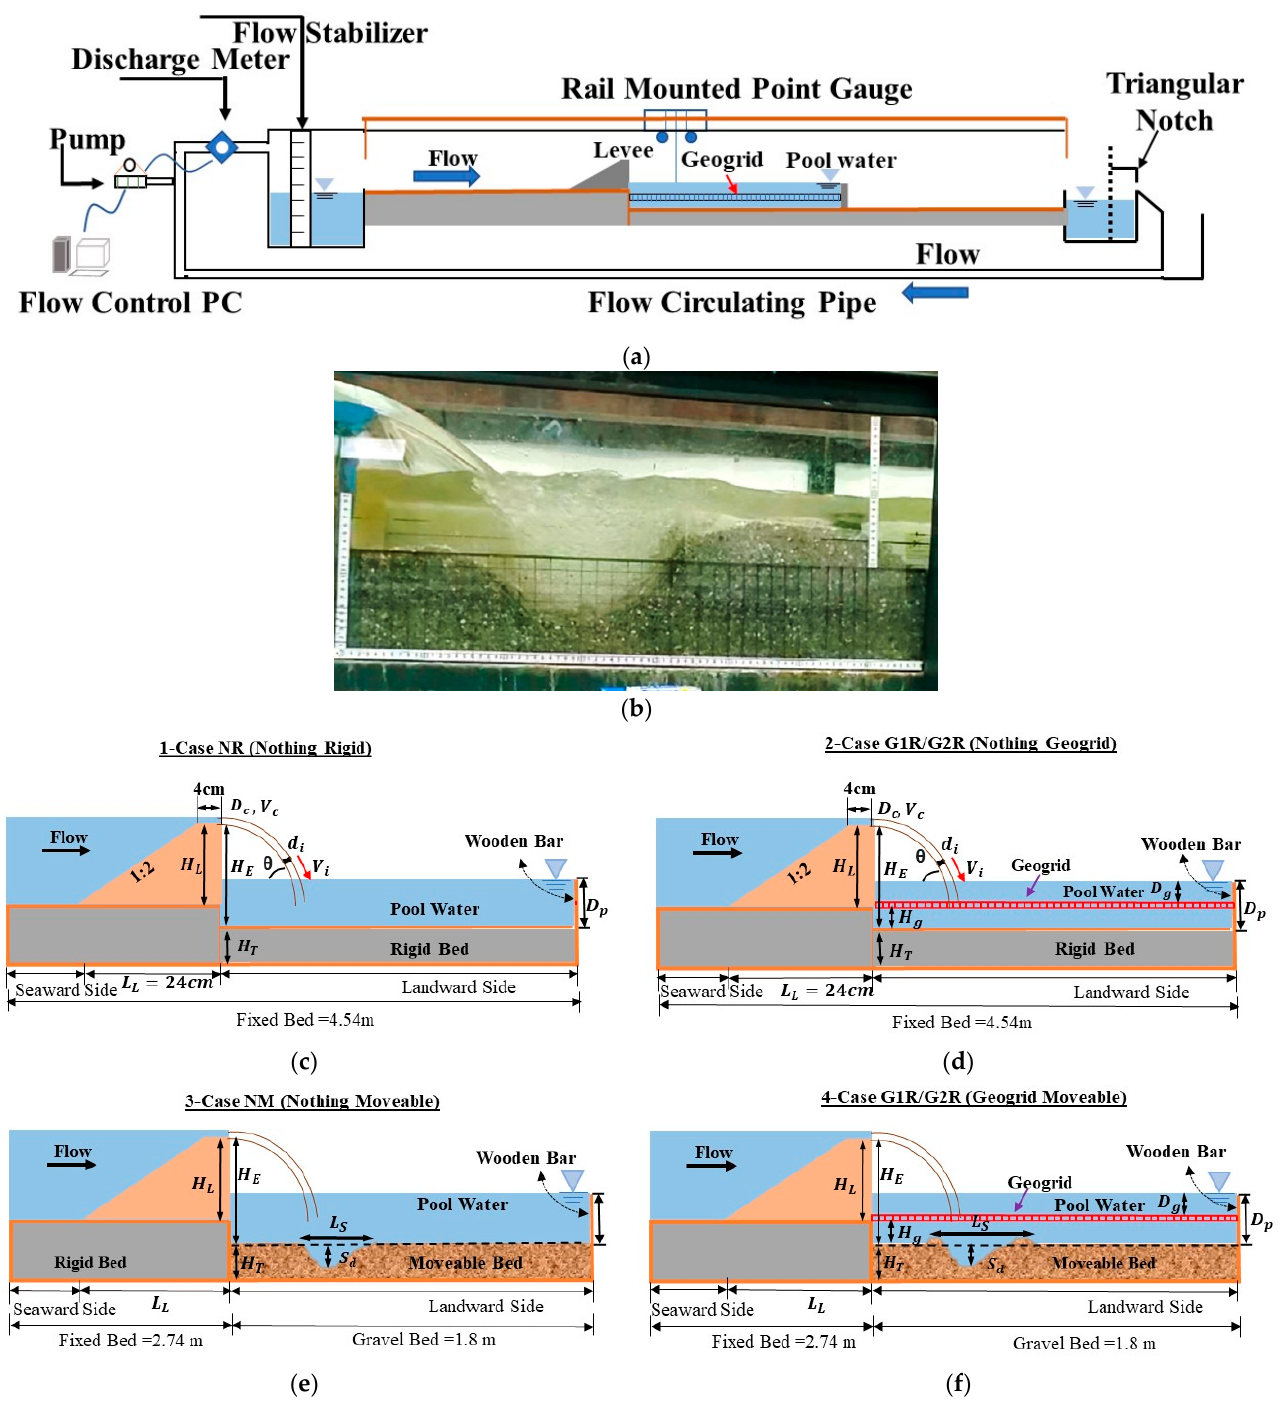
Figure 2. ( a ) Schematics of experimental setup, ( b ) picture of experimental setup. ( c ) Test section for nothing rigid bed (NR) experiments, ( d ) for geogrid rigid bed (G1R/G2R) experiments, ( e ) for nothing moveable bed (NM) experiments and ( f ) for geogrid moveable bed (G1M/G2M) experi ‐ ments.